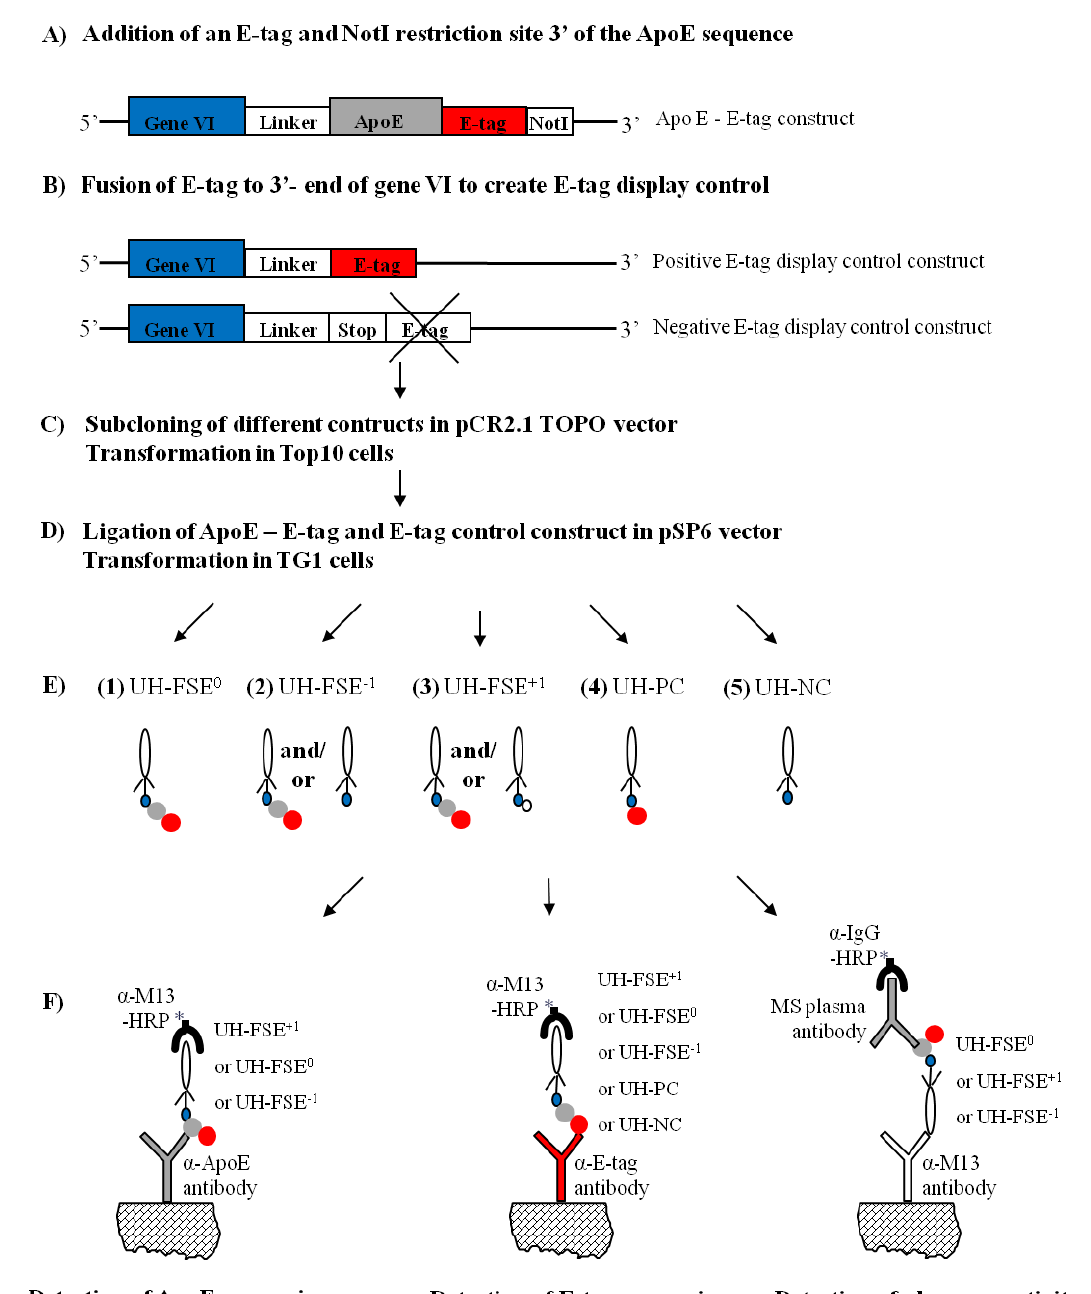
Figure 2. Overview of the study. First the E-tag (red) was coupled to the 3’ site of the ApoE sequence (grey) (A) and E-tag display controls were made (B) . After cloning the constructs into the pCR2.1 TOPO vector and pSP6 vectors (C-D) , different phages were purified (E) . Phage UH-FSE 0 correctly displays the ApoE polypeptide (grey) and E-tag (red) fused to p6 (blue) (E1) . UH-FSE − 1 (E2) and UH-FSE +1 (E3) express the ApoE construct with, respectively, a − 1 and +1 shift in the reading frame. Although these phages normally do not express the ApoE polypeptide, part of them will if frameshifting would occur. A positive (E4) and negative (E5) E-tag display control was also purified. Expression of both ApoE polypeptide and E-tag were subsequently measured by ELISA (F)